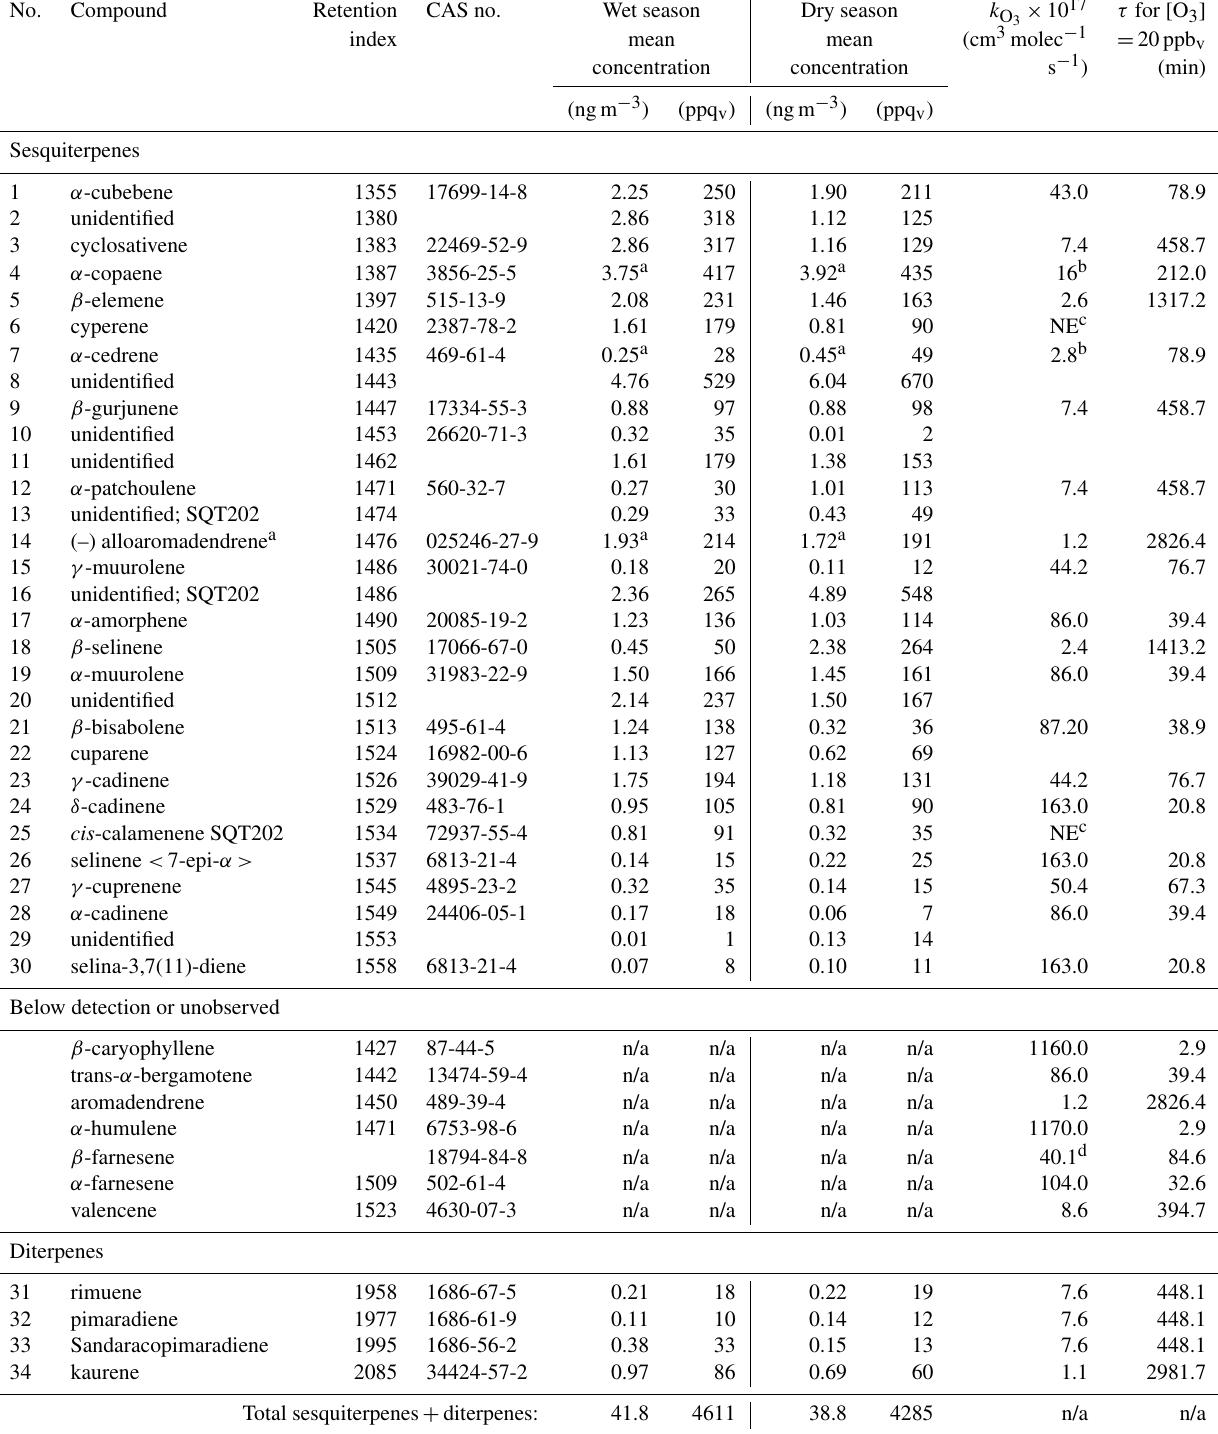
Table 1. Sesquiterpenes and terpenoids observed in the gas phase during GoAmazon2014/5 with proposed identification and their alkane- based retention index, Chemical Abstracts Service (CAS) number, mean concentration during wet and dry seasons, reaction rate constant with O 3 ( k O ), and estimated chemical lifetime in the presence of 20ppb v O 3 . k O is estimated using EPA EPI Suite 4.1 AOPWIN where 3 3 literature data are unavailable. Concentrations of each species are estimated by using an average instrument response factor for several sesquiterpene standards unless otherwise noted that an authentic standard was used. Other commonly studied sesquiterpenes typically below detection or unobserved are also included for comparison of reactive